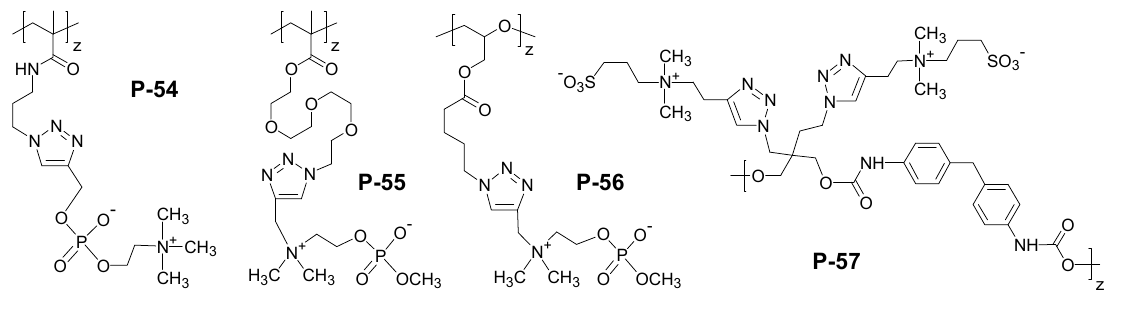
Figure 12. Polyzwitterions made by post-polymerization Huisgen